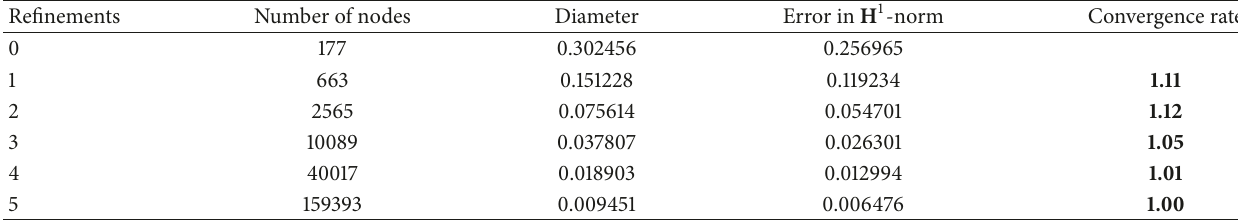
Table 5: Order of convergence in H 1 -norm for simply supported plate.